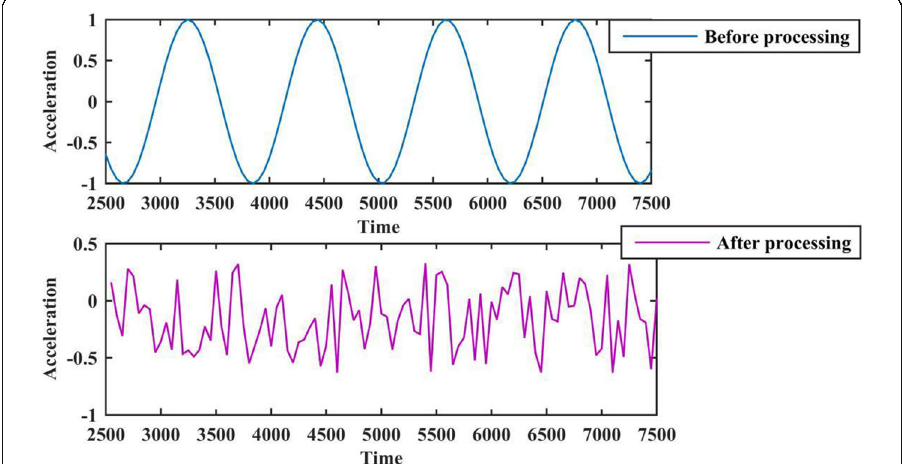
Fig. 7 Acceleration sensor data processing before and after